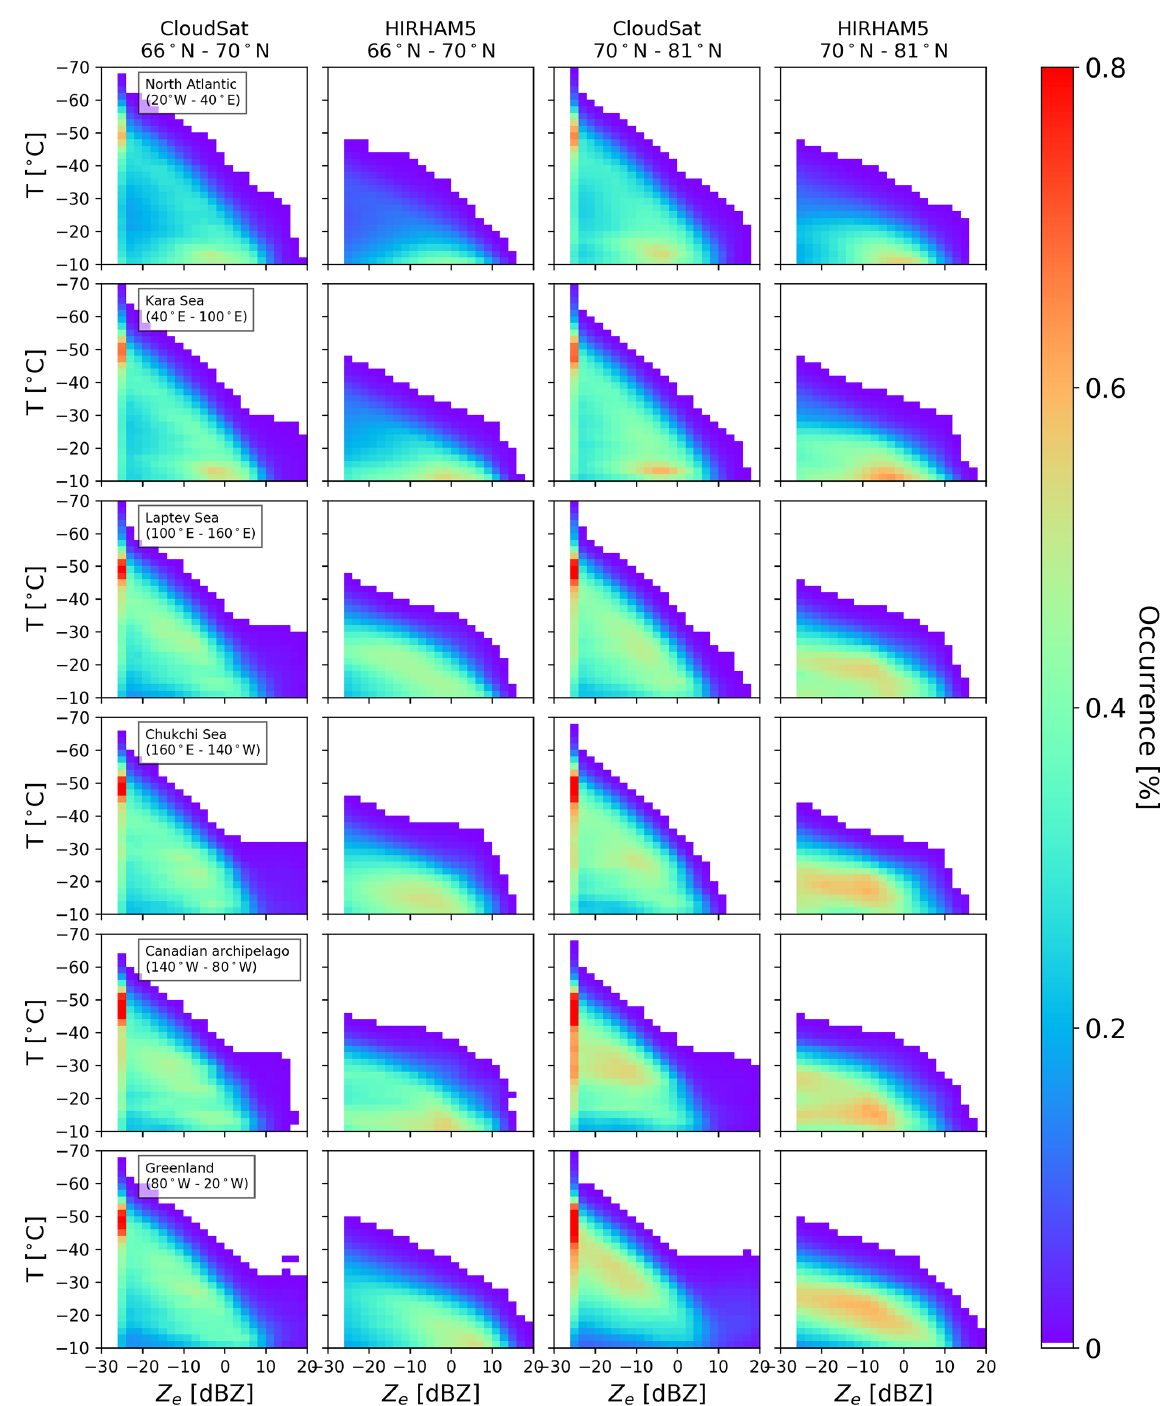
Figure A7. The observed and modeled CFTDs for both latitude band regions in the spring season (MAM, 2007–2010). On the x axis is the reflectivity in dBZ, and on the y axis is the temperature from − 70 to − 10 ◦ C. The normalization is done by the sum of total